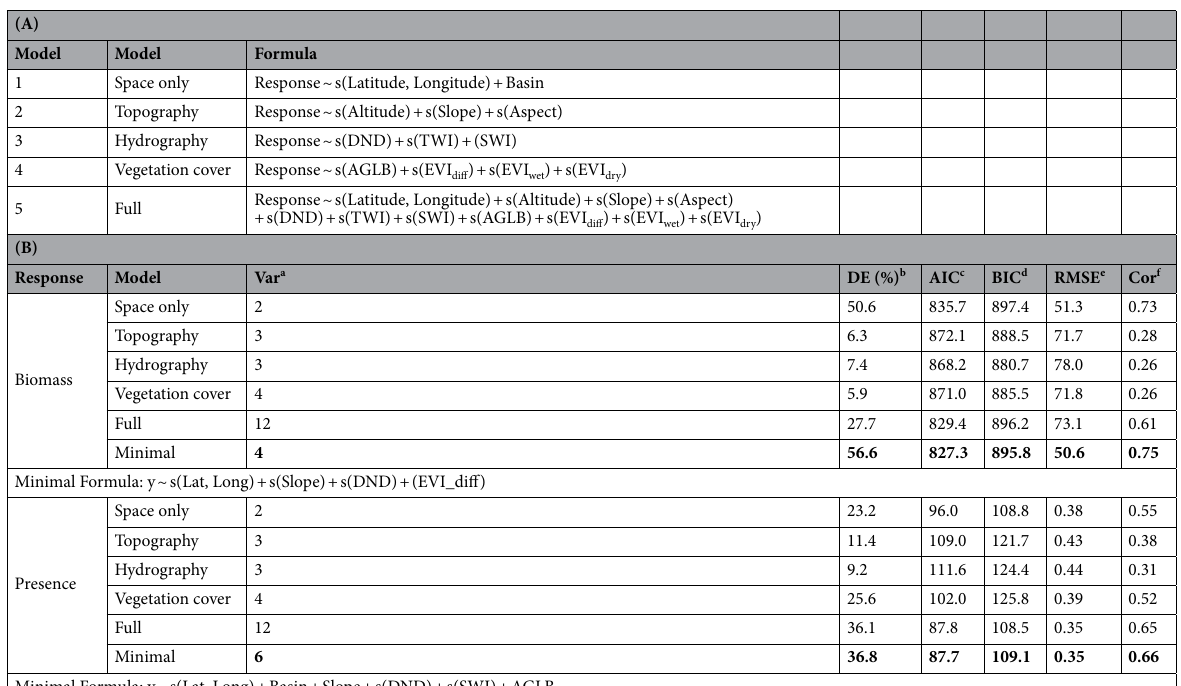
Table 2. Explaining fruit-fall patterns. Models used to explain patterns of Vouacapoua americana fruit-fall recorded in 90 survey plots in the Amapá National Forest. ( A ) A priori models and formulas applied to test multiple hypotheses for each response. ( B ) Summary of GAM results for each model and for each response. Variable acronyms: TWI Topographic wetness index, SWI SAGA wetness index, DND distance to network drainage, AGLB above ground live biomass, EVI enhanced vegetation index. a Number covariates included in model. b Percentage of Deviance Explained for each model (DE (%)). c Akaike Information Criterion value for each model (AIC). d Bayesian Information Criterion values for each model (BIC). e Root mean square error (RMSE) between observed and fitted model values. f Pearsons correlation between observed and fitted model values from the 90 sample